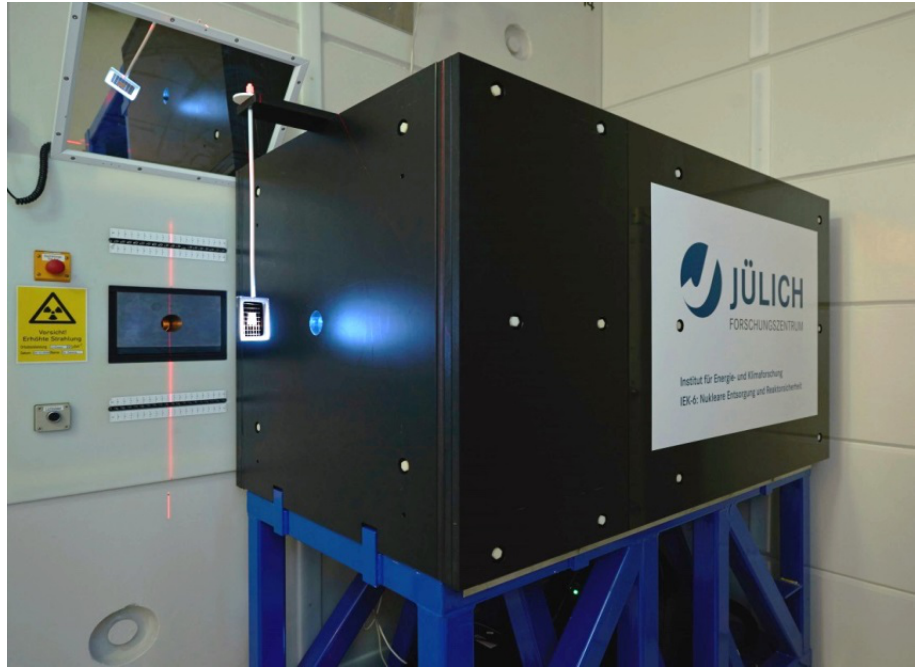
Figure 1: FaNGaS set-up with neutron collimator, gamma counting and sample positioning system in the MEDAPP bunker (picture: TU München, W. Schürmann. Also submitted to Journal of Radioana- lytical and Nuclear Chemistry article ‚Prompt and delayed inelastic scattering reactions from fission neutron irradiation - first results of FaNGaS‘(JRNC-D-15-01030)). Efficiency calibration for both positions has been achieved by measurement of calibrated radioactive sources (PTB) and a thermal irradiation of Cl (PVC) for the high energy region of the gamma spectrum. The energy distribution of the fission neutron beam of SR10 after installation of the neutron collima- tors has been determined by the metal foil irradiation technique using nuclear threshold reactions and unfolding software STAYSL PNNL (see FIG